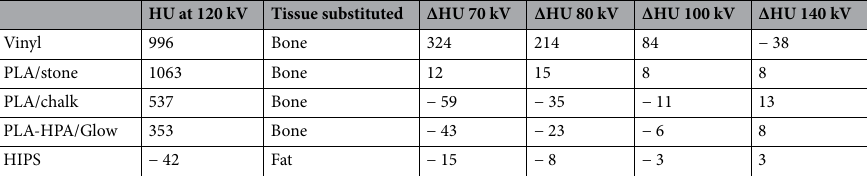
Table 2. CT numbers of common printing materials best simulating bone and adipose tissue, and differences to tissue with equal CT value at 120 kV. Note: value at 120 kV is not provided, since